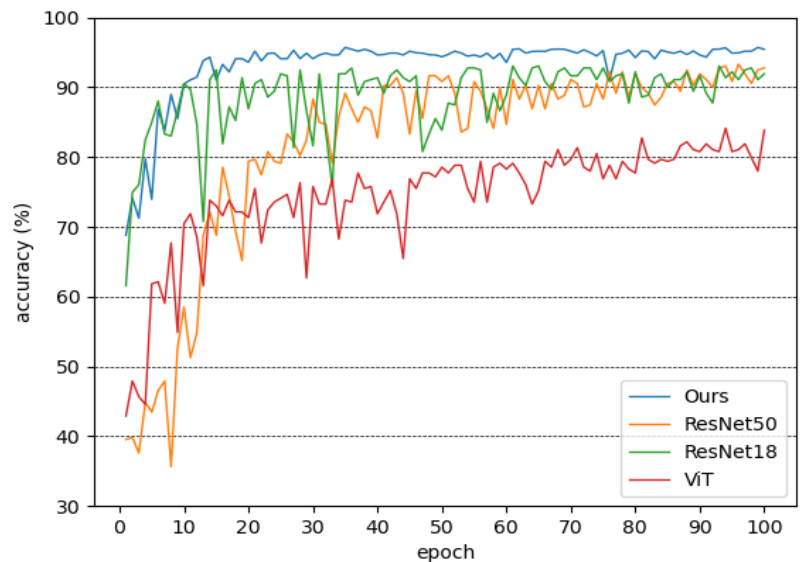
Figure 10. Accuracy of the classifiers in the test set.